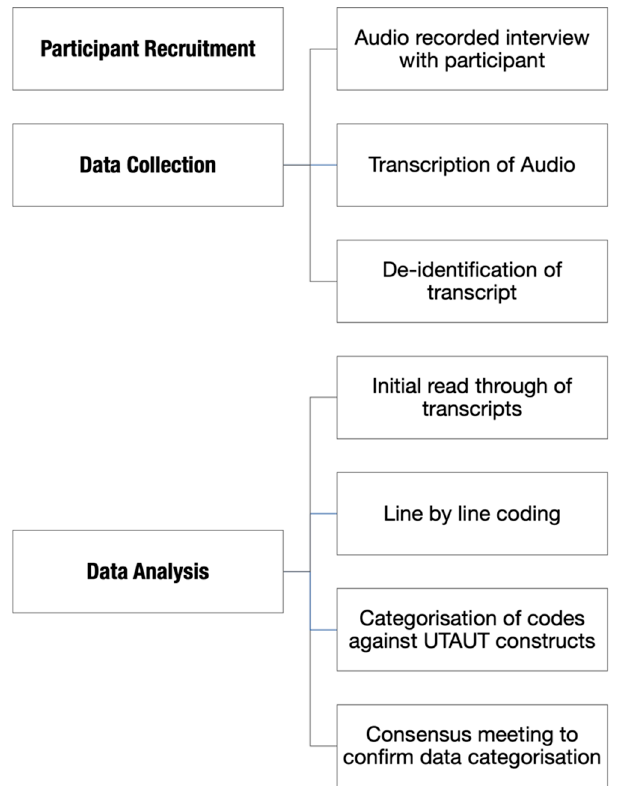
Figure 1. Process diagram showing how the study data was collected and analysed. UTAUT: Unified Theory of Acceptance and Use of Technology.